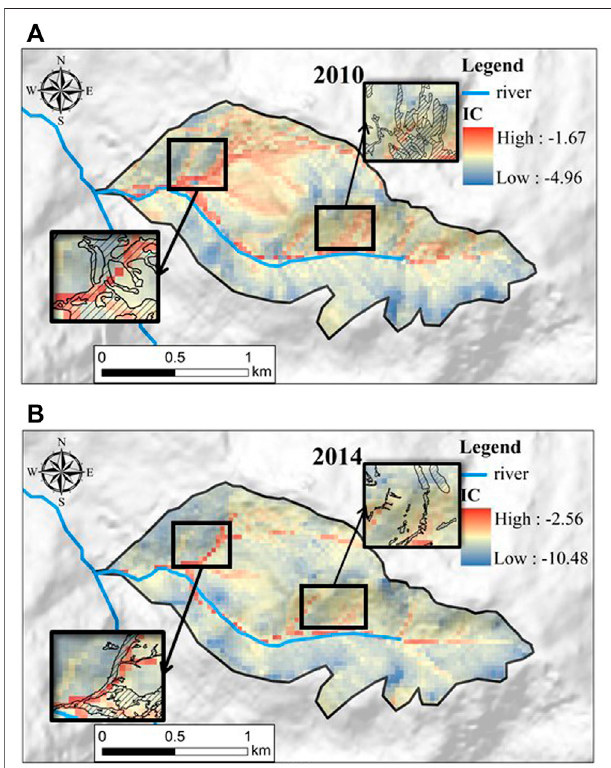
FIGURE13| Comparingthedistributionoflandslidesandcollapseswith the distribution of the sediment connectivity in tributary 1 in (A) 2010 and (B) 2014. In 2010, the distribution of landslides and collapses is consistent with distribution of high IC values. In 2014, the areas of landslide and collapses are decreasing, as are the areas with high IC